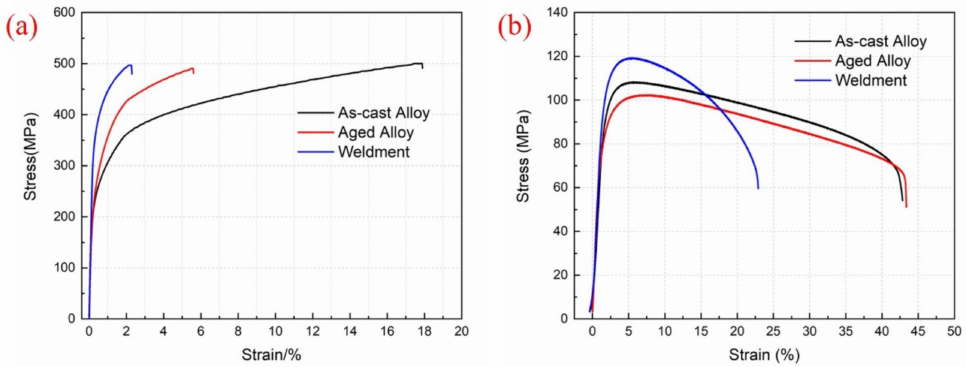
Figure 9. Typical stress–strain plots of the as-cast alloy, aged alloy, and fresh-to-aged welded joint at ( a ) room temperature and ( b ) elevated temperature (950 ◦ C). Table 3. Tensile properties of the as-cast HP40Nb alloy, aged alloy, and fresh-to-aged welded joint.